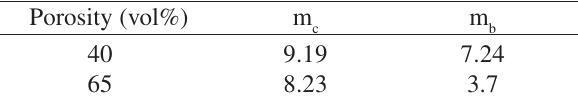
Table 2. Weibull moduli for porous GR-HA specimens tested un- der compression and bending.